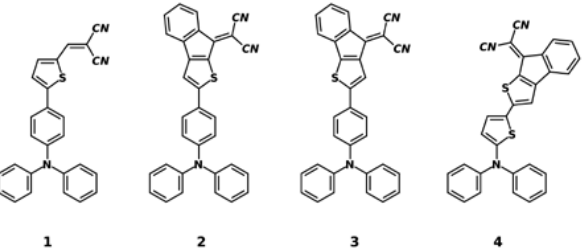
Figure 1. Structural formula of compounds 1 , 2 , 3 , and 4